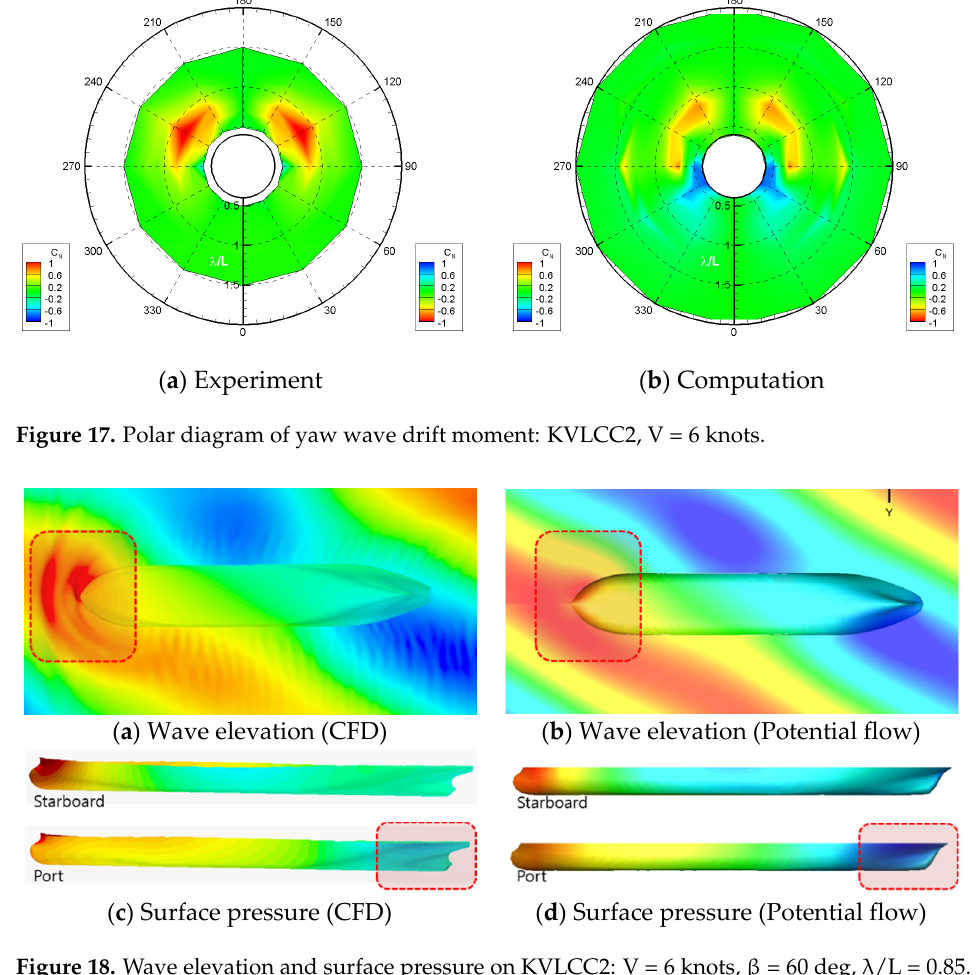
Figure 16. Yaw drift moment on KVLCC2: V = 6 knots, H/L = 1/50.